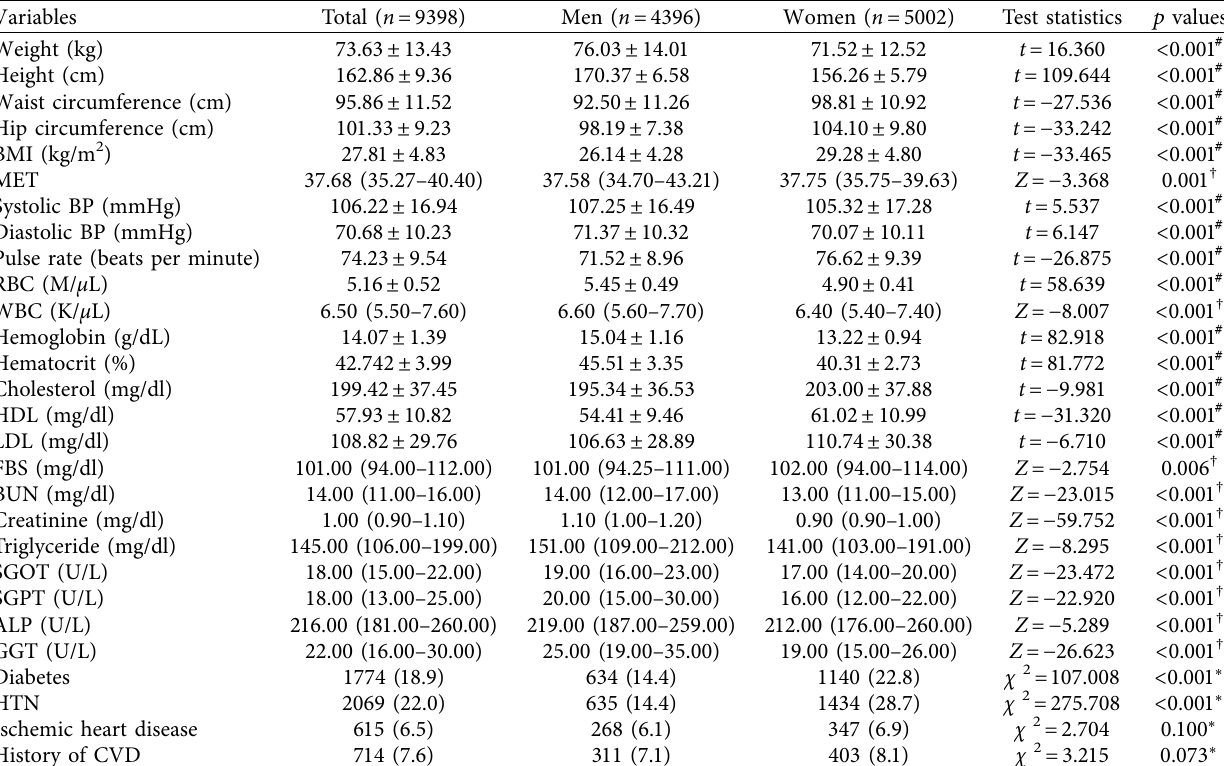
Table 2: Baseline clinical and anthropometry characteristics of the study participants based on